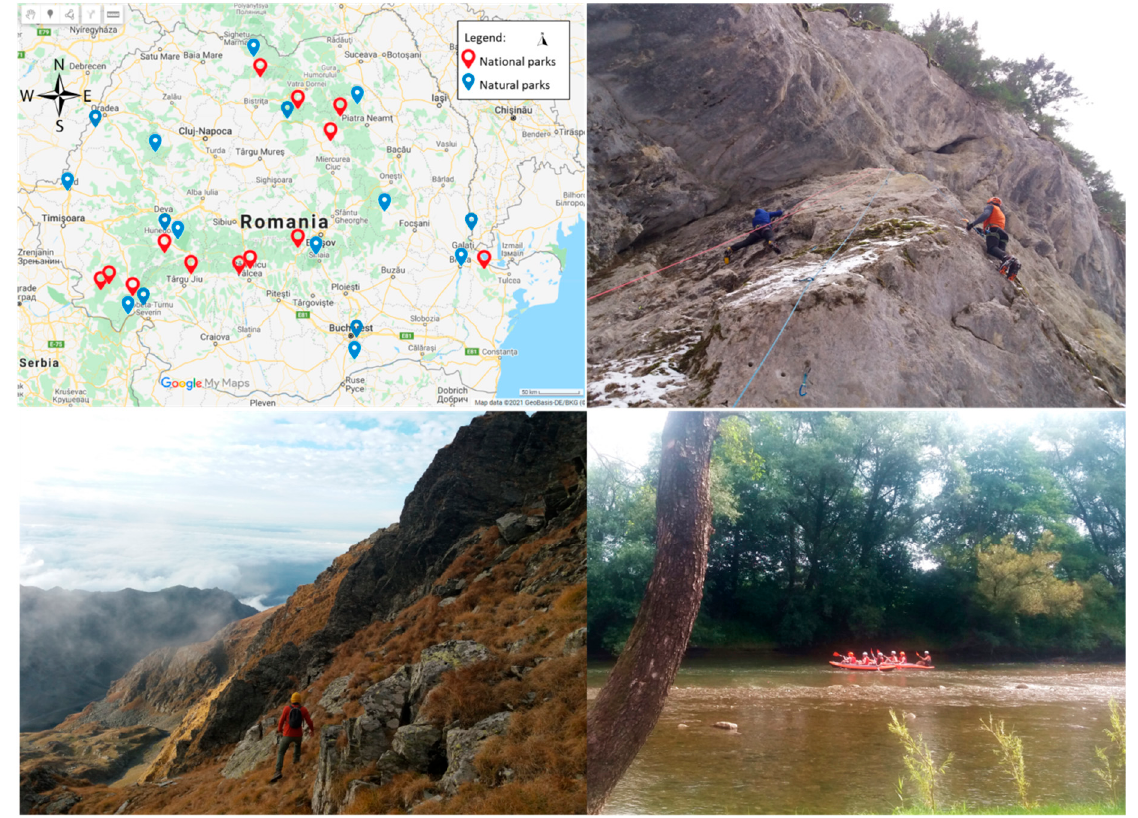
Figure 1. Location of national and natural parks in Romania and examples of adventure tourism. Source: Map created using Google maps; photos taken by Delia Donici.